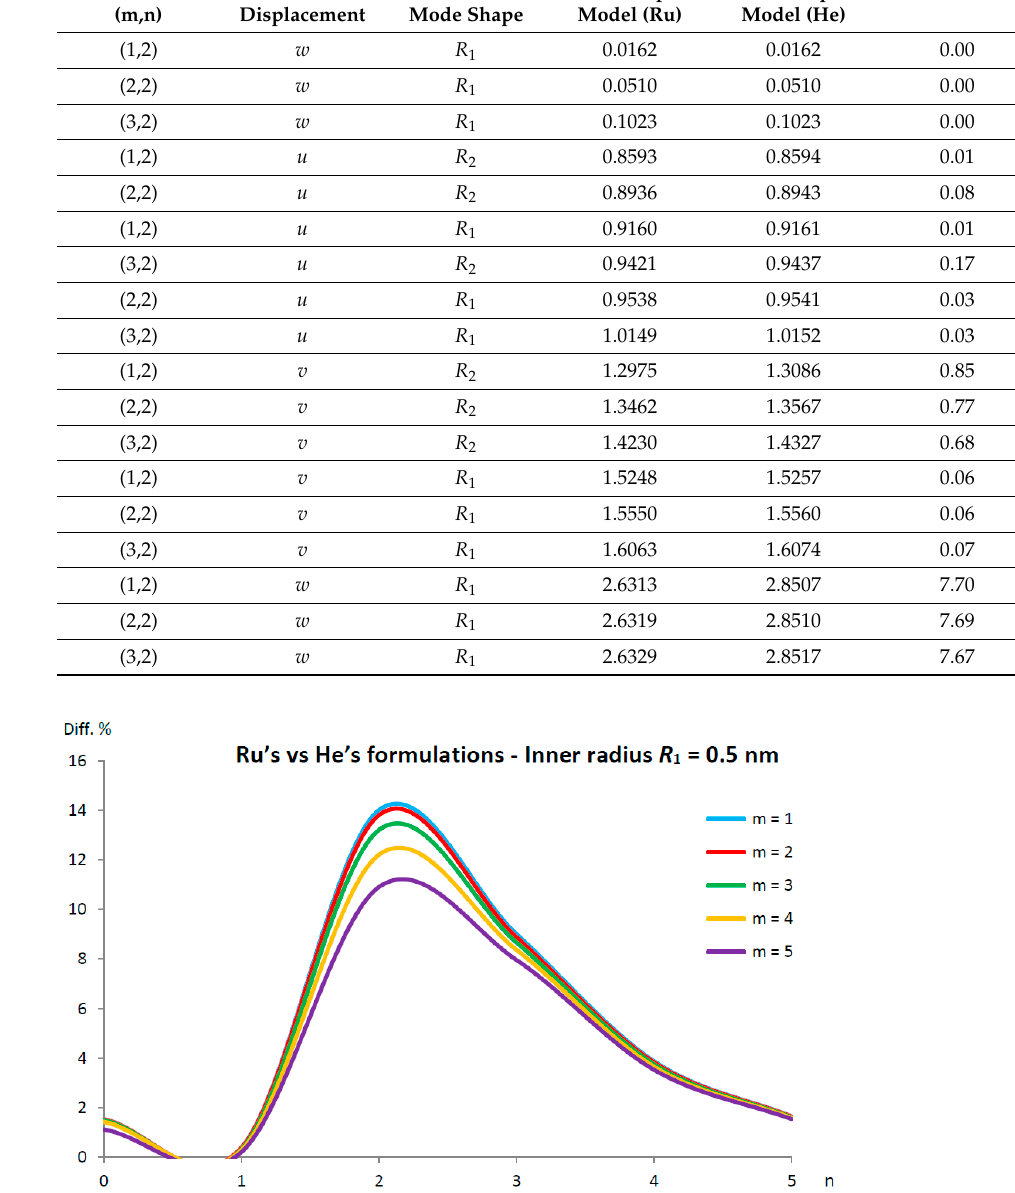
Figure 5. Percentage differences between the highest radial natural frequencies of the simply sup- ported DWCNT of Table 1 with inner radius R 1 = 1 nm and aspect ratio L / R 2 = 10 from Ru’s (38) and He’s (39) formulations. Donnell shell theory. Anisotropic elastic shell model. Number of lon- gitudinal half-waves m . Number of circumferential waves n.